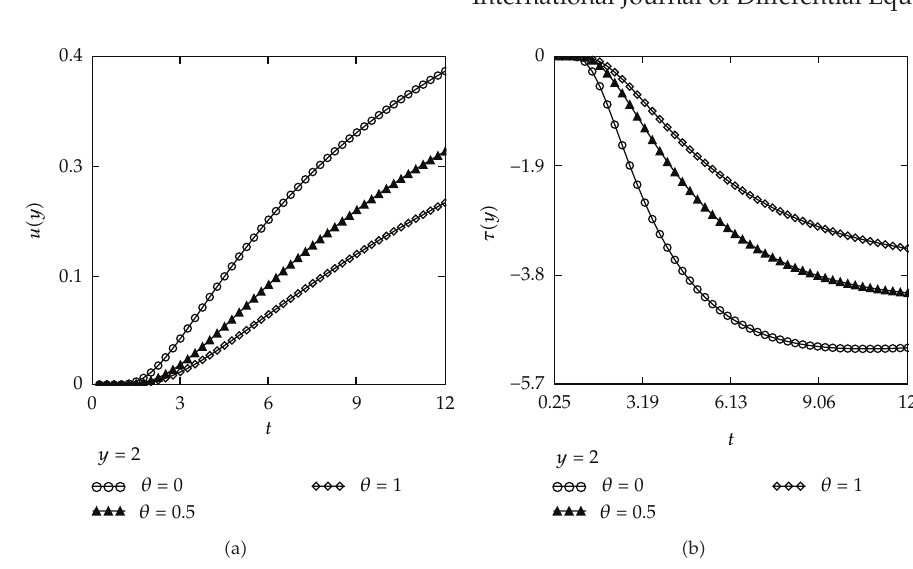
Figure 4: Profiles of the velocity field u (cid:4) y,t (cid:5) and the shear stress τ (cid:4) y,t (cid:5) for fractional Maxwell fluid given by (cid:4) 4.7 (cid:5) and (cid:4) 4.15 (cid:5) , for U (cid:9) 1, y (cid:9) 2, ν (cid:9) 0 . 379, μ (cid:9) 33, λ (cid:9) 1 . 5, α (cid:9) 0 . 2, and di ff erent values of θ .